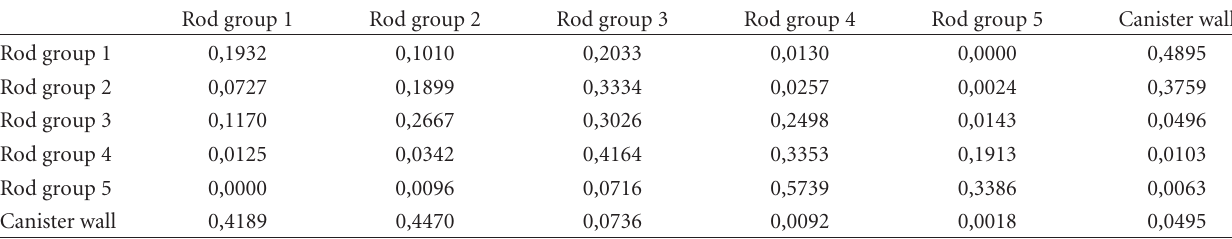
Table 2: View factors from the G ¨OTA documentation [3].